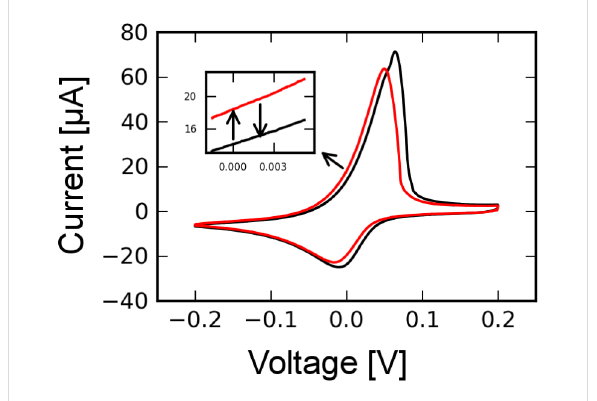
Figure 5: Cyclic voltammogram (CV) of AgNO 3 at 35 °C (black) and 45 °C (red), scan rate was 50 mV/s. The temperature is increased by